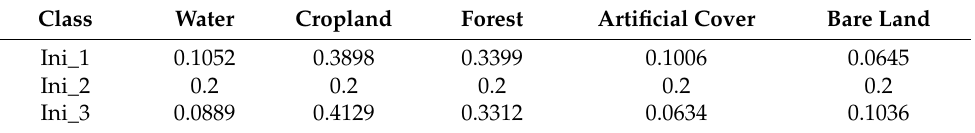
Table 1. Initial probability distribution of 5 land cover classes.